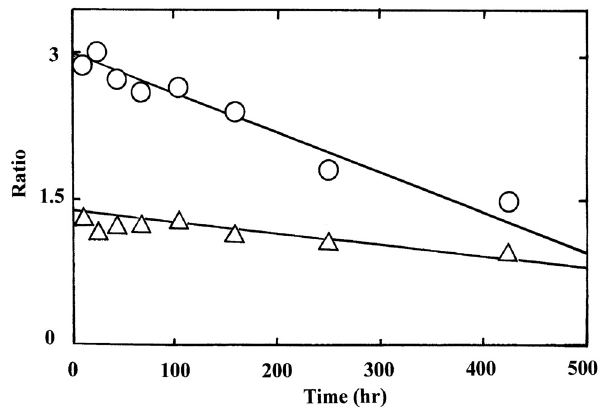
Figure 11. Peak-height ratios of II/I and VI/V versus time plots. Peak-height ratios of II/I ( ○ ) and VI/V ( △ ) in each column shown in Figure 9 were plotted against